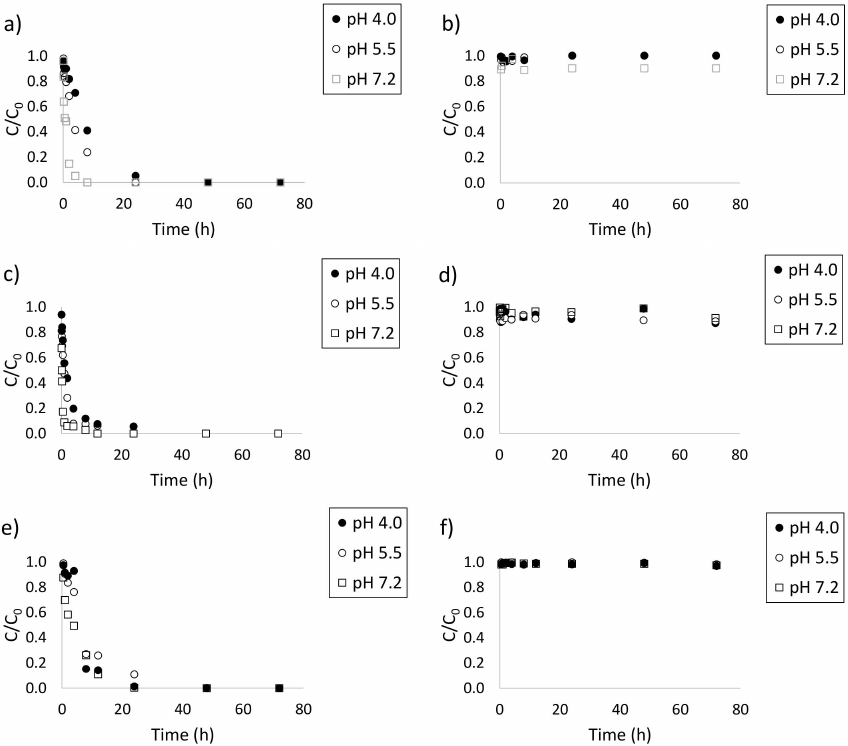
Figure 1. Degradation kinetics of the three antibiotics: ( a ) Doxycycline (DC) under simulated sunlight; ( b ) DC in the dark; ( c ) Enrofloxacin (ENR) under simulated sunlight; ( d ) ENR in the dark; ( e ) Sulfamethoxypyridazine (SMP) under simulated sunlight; ( f ) SMP in the dark. The values of the coefficients of variation were ≤ 10% in all